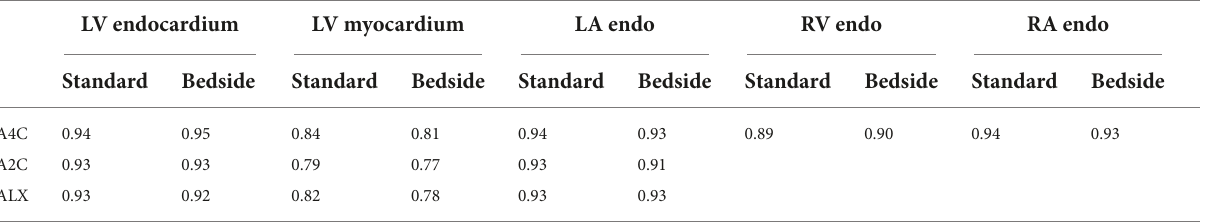
TABLE 2 Performance of the segmentation model.